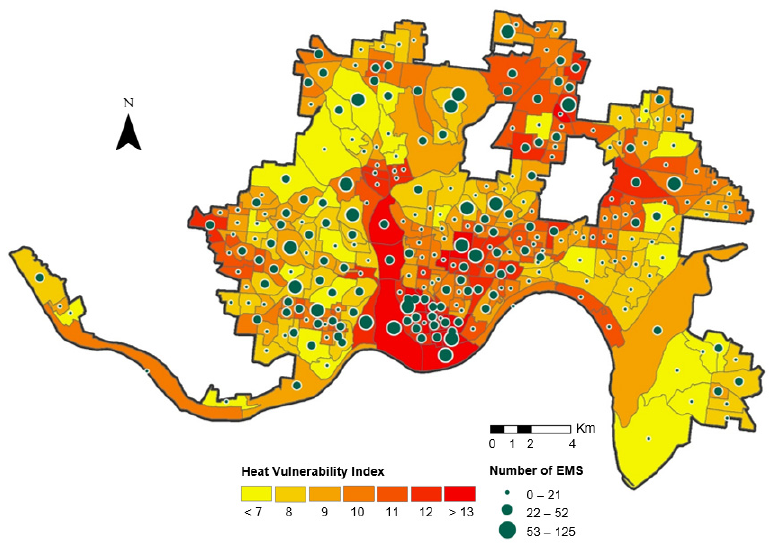
Figure 3. Heat vulnerability map and spatial distribution of heat-related EMS incidents for census block groups. block